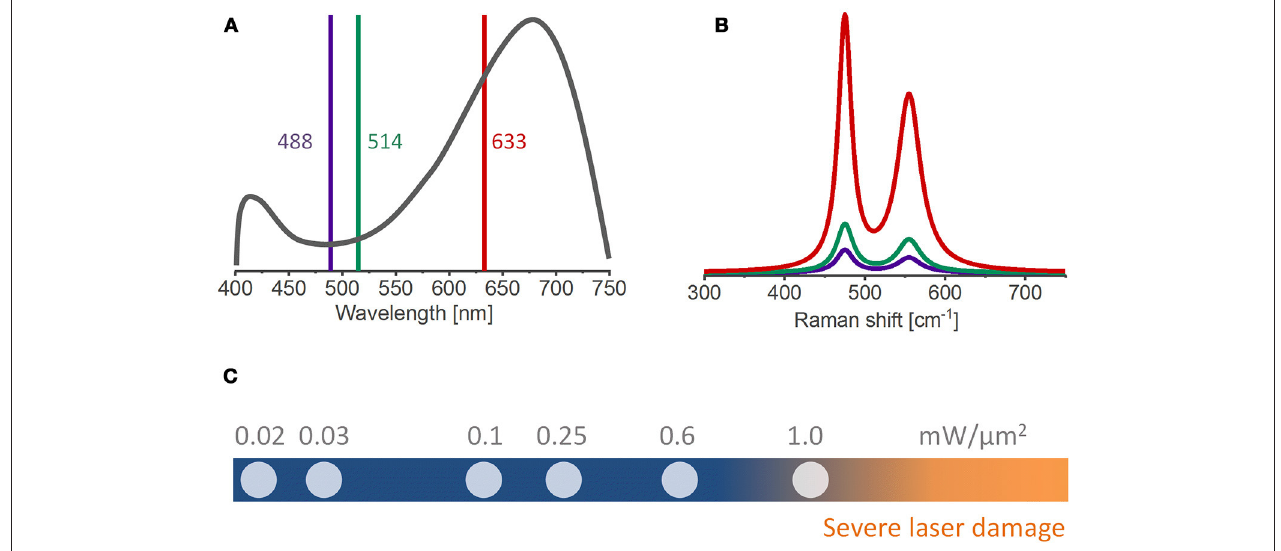
FIGURE 2 | (A) UV-Vis and (B) Raman spectra of HNiO 2 using different excitation wavelengths [adapted from reference (Chen et al., 2016)]. The 633nm wavelength, closest to the absorption maxima of the material, yield enhanced Raman bands. (C) A range of laser specific powers commonly used in ex situ and in situ Raman measurements. The risk of laser-induced sample burning and/or structural changes increases for laser powers above 1 mW/ µ m 2